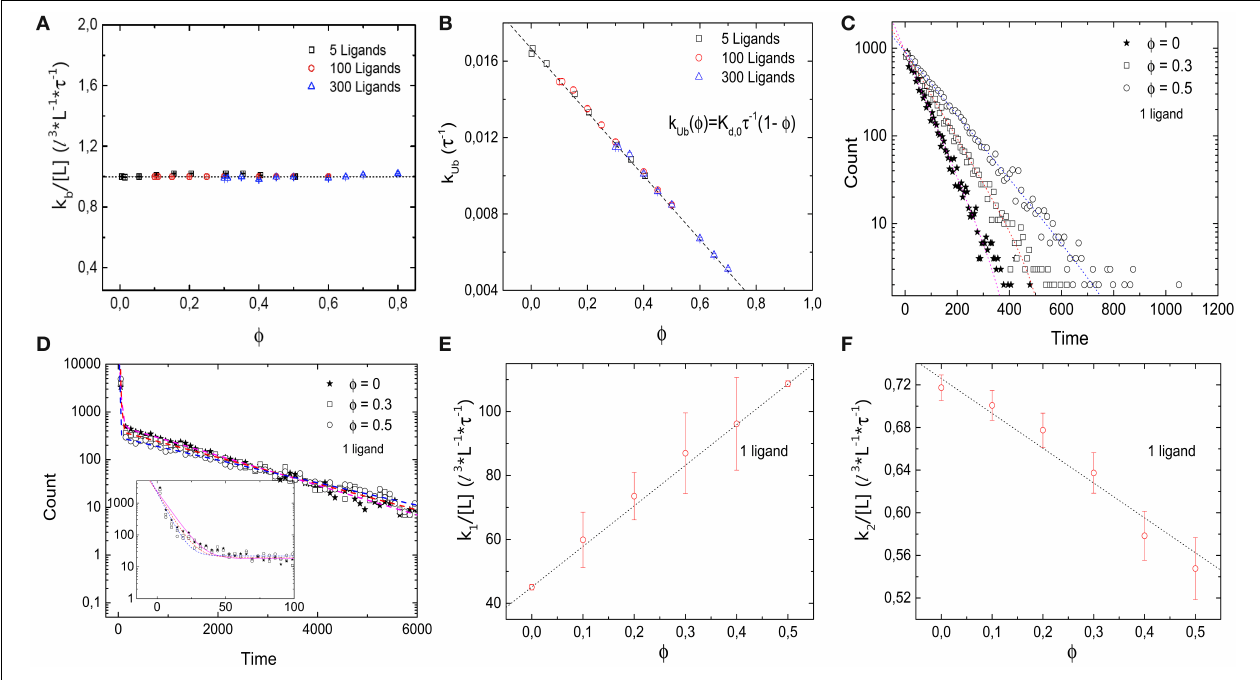
FIGURE 3 | Kinetics of the simple binding reaction model. (A) Binding the duration of 10,000 binding events for φ 0 , 0 . 3 , 0 . 5 and a single ligand. = rate k b and (B) unbinding rate k ub , as a function of the volume occupation A double exponential decay is observed with a fast and slow component in fraction φ . k b remains constant for all values of φ . Thus, diffusion of the ligand the binding kinetics. Inset: closeup of the histogram for short times with toward the target is not affected by crowding. k ub decays as φ increases, in smaller bin size. (E) Fast rebinding is enhanced when levels of molecular agreement with the expression k ub crowding increase. (F) Slow rebinding is negatively affected when φ K d , 0 τ − 1 (1 φ ) . (C) Histograms of the = − duration of 10,000 unbinding events for the case of a single ligand for increases, since the diffusion of the ligand toward the target is hindered. different values of φ . The data follow a single exponential. (D) Histograms of Simulation parameters as in Figure 2